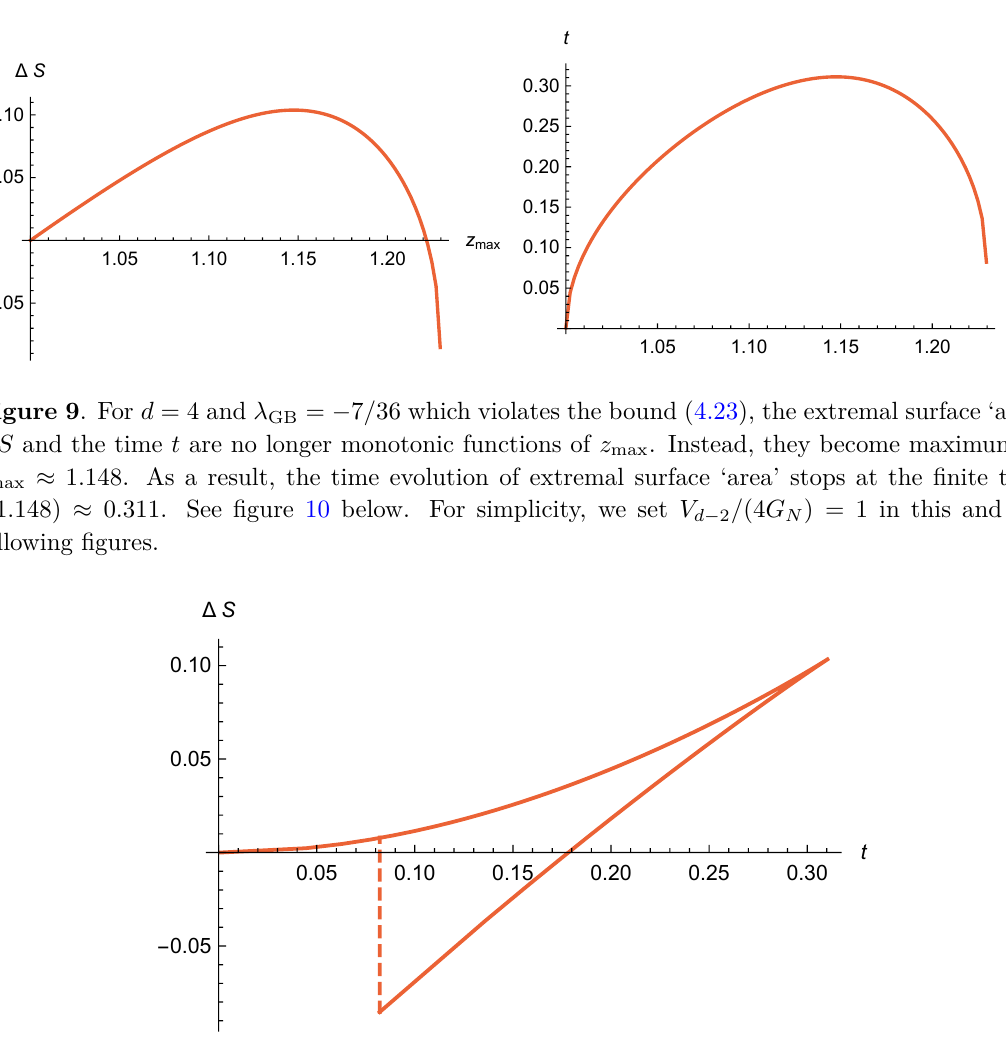
In other words, the time evolution of entanglement entropy is discontinuous. Take d =